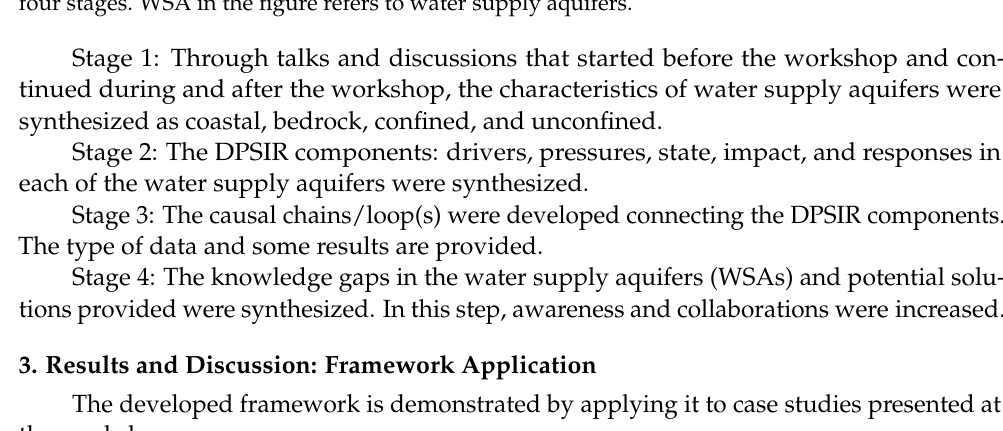
Figure 1. ( a ) Overview of the sustainable groundwater development tool. ( b ) Brief description of the four stages. WSA in the figure refers to water supply